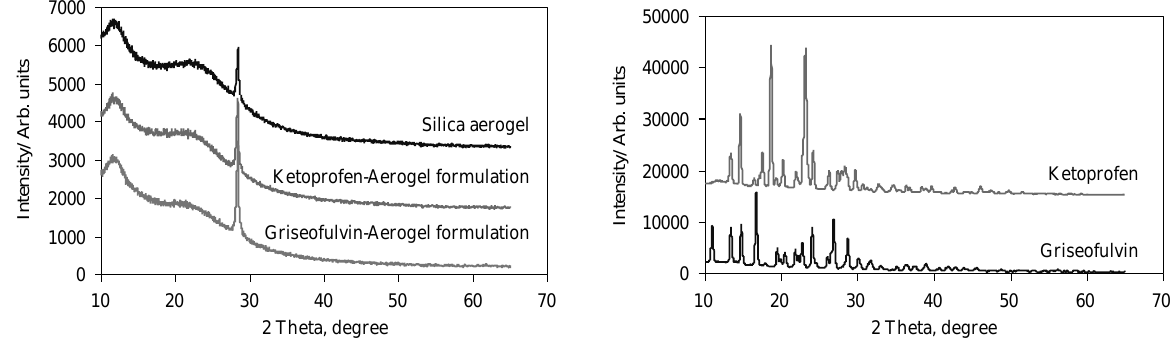
X-ray diffraction patterns of a) silica aerogel and drug-aerogel formulations; b) crystalline ketoprofen and